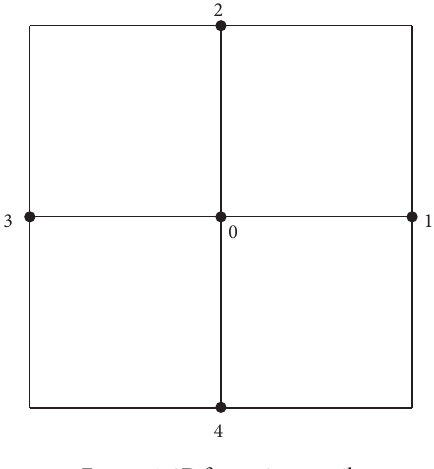
Figure 1: 2D five-point